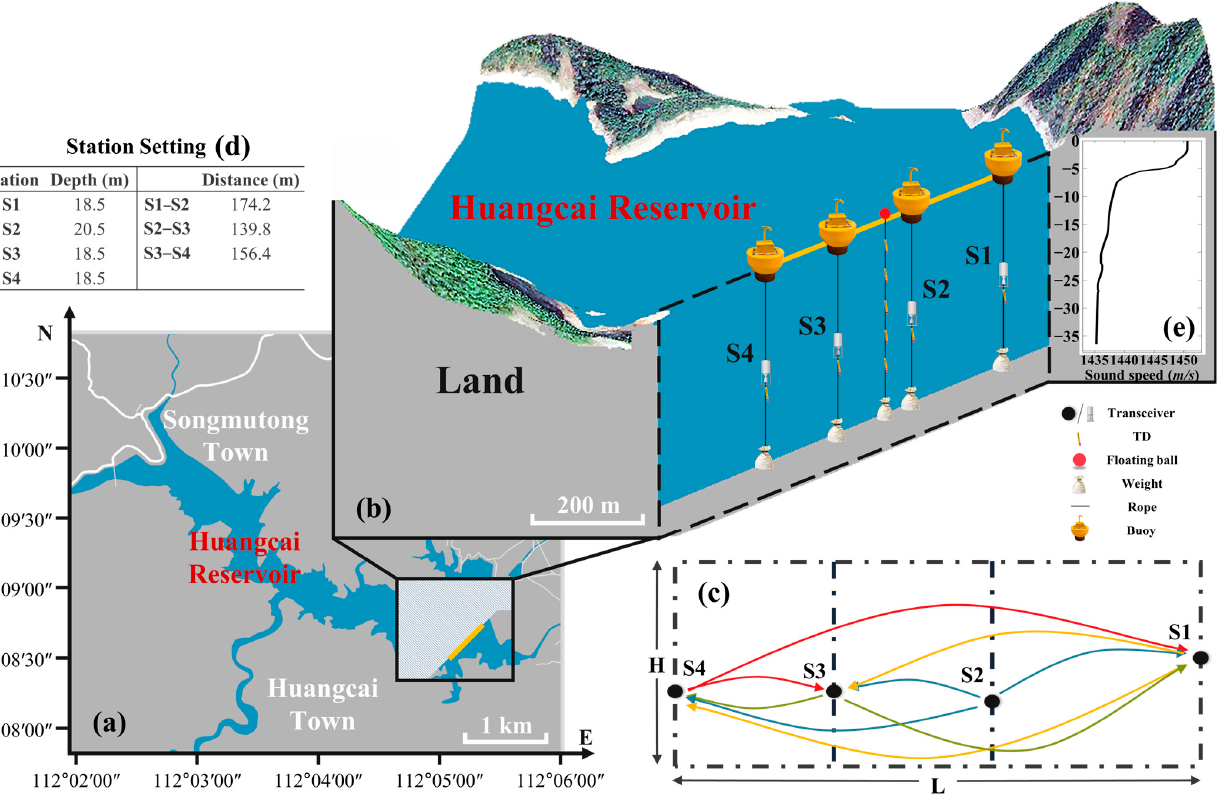
Figure 2. Experiment setting: ( a ) is the map of Huangcai Reservoir and adjacent regions; experiment settings are magnified in ( b ), which shows the position of CAT stations (S1, S2, S3, and S4) and the position of TD array; ( c ) is the transmission mode between different stations; ( d ) is the table of station depth and distance; ( e ) is the sound speed profile measured by CTD during the experiment.